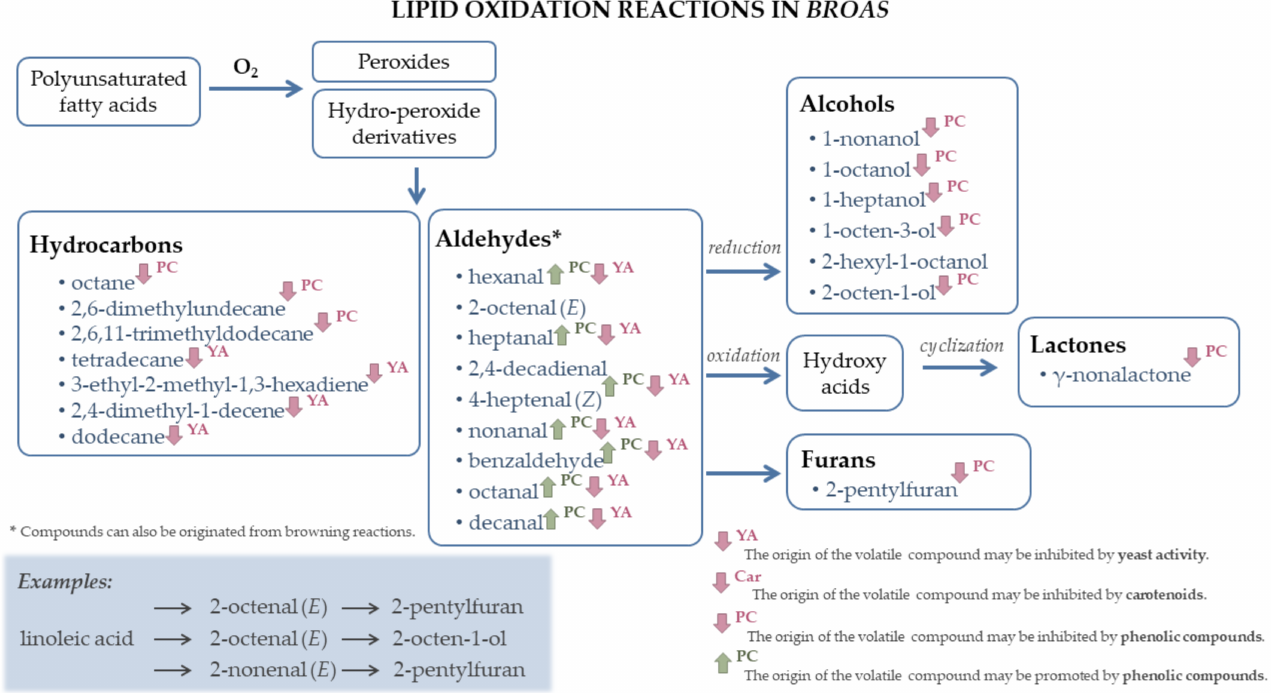
Figure 4. Representative scheme of lipid oxidation reactions [15,17,20,28,35] in broas